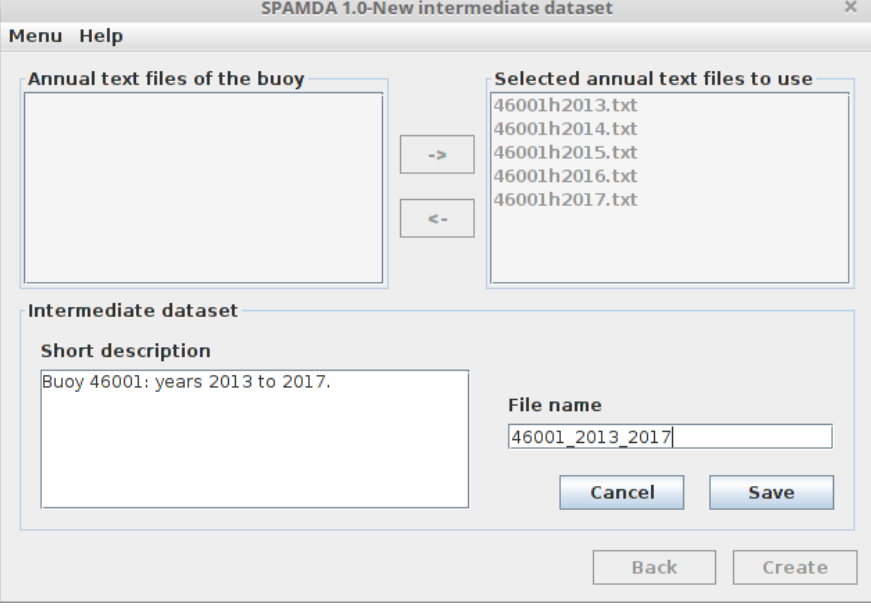
Figure 17. New intermediate dataset view: creating the intermediate dataset with five annual text